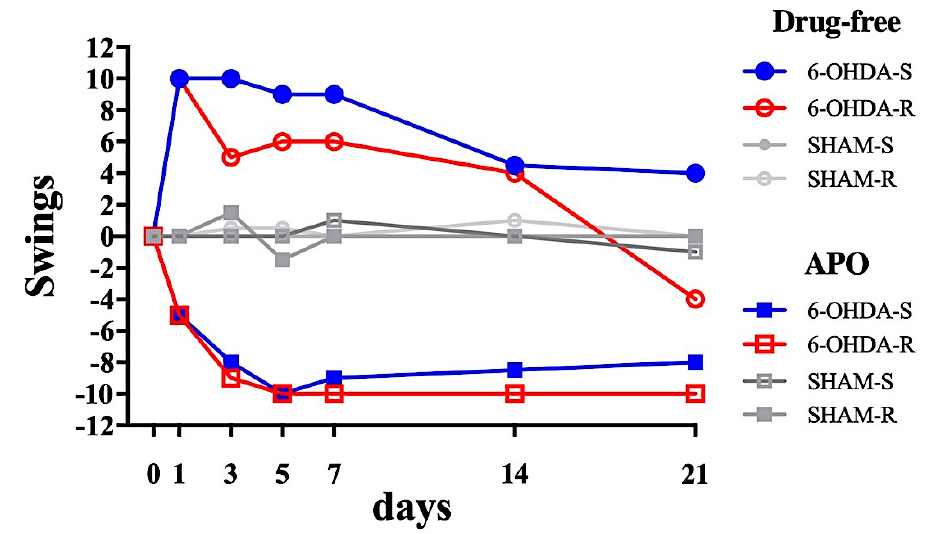
Figure 1. Time course of the number of swings assessed by the tail suspension swing test (TSST) for the SHAM and 6-OHDA lesioned rats in drug-free (circles) and apomorphine (APO, squares) induced condition. Day 0 represents the pre-surgery testing. 6-OHDA-S (blue) and 6-OHDA-R (red) are rats subjected to single (on the sacrifice day) or repeated (all testing days until sacrifice day) APO administration, respectively. Positive values indicate ipsilateral swings; negative values indicate contralateral swings. See Table S1 for the statistical difference between 6-OHDA and SHAM groups, and between time points to the pre-surgery condition (day 0).